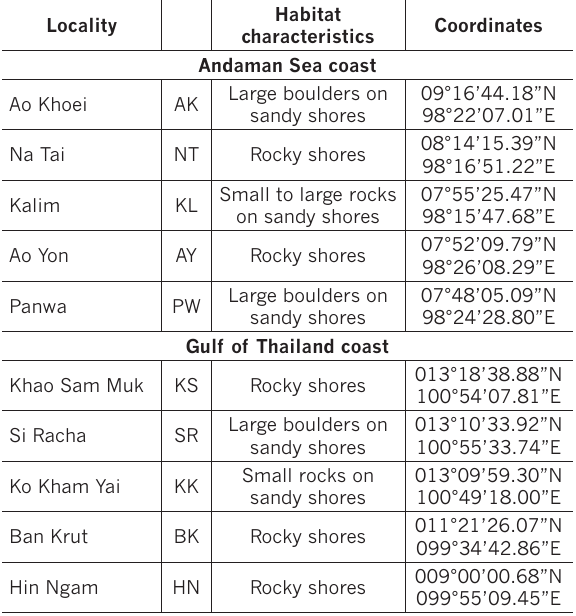
Table 1. Sampling locations, arranged from north to south. Habitat Locality